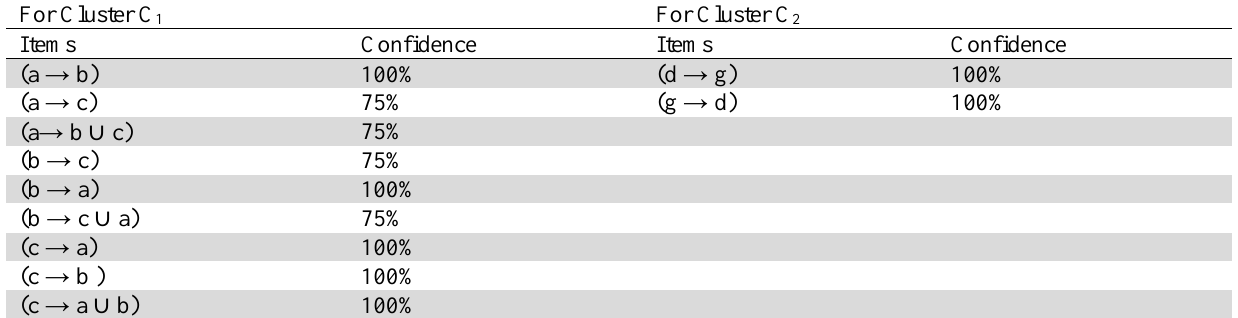
Confidence of frequent item-set in Cluster C 1 and Cluster C 2 For Cluster C 1 For Cluster C